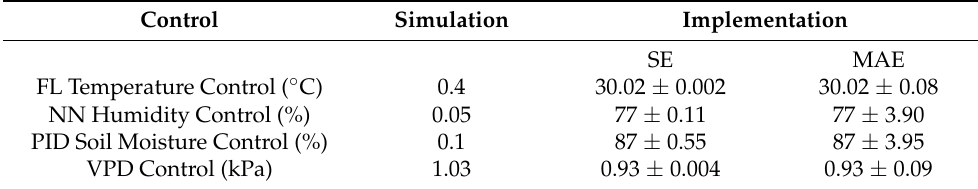
Table 4. Error comparison in simulation and